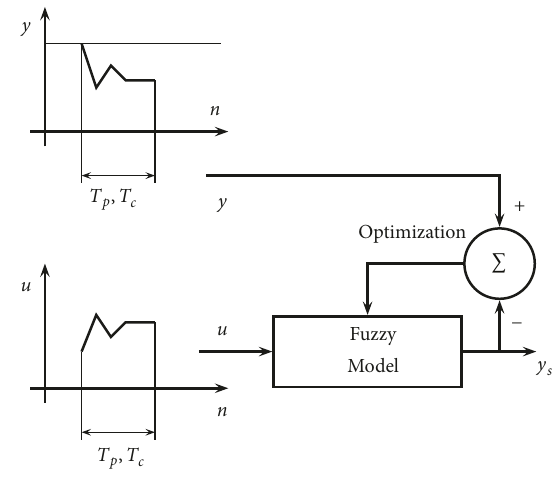
Figure 6: Plant model